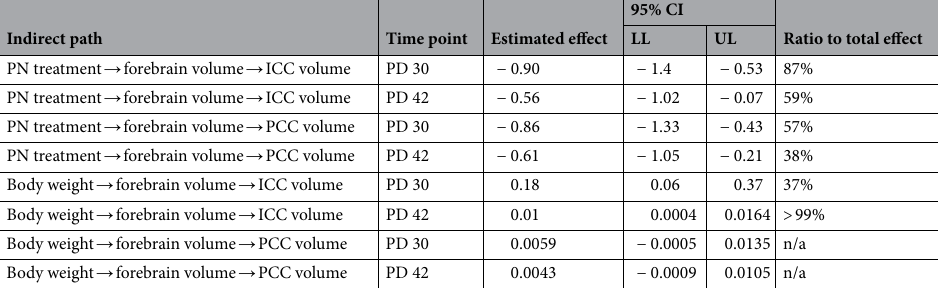
Table 2. Regression-based mediation analyses illustrating the indirect effects of forebrain volume on ICC/ PCC volume for PD30 and 42. If a 0 falls within the bounds of the bootstrapping confidence interval (CI), then the proposed relationship does not exist. N = 80, bootstrapping sample size = 500, LL lower limit, UL upper limit, CI confidence interval, all effects are partially standardized.